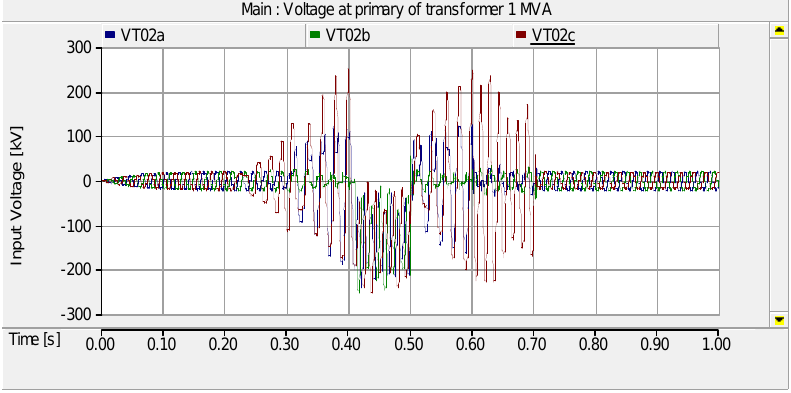
Figure 13. The ferroresonance overvoltage at the HV side transformer 1 MVA.